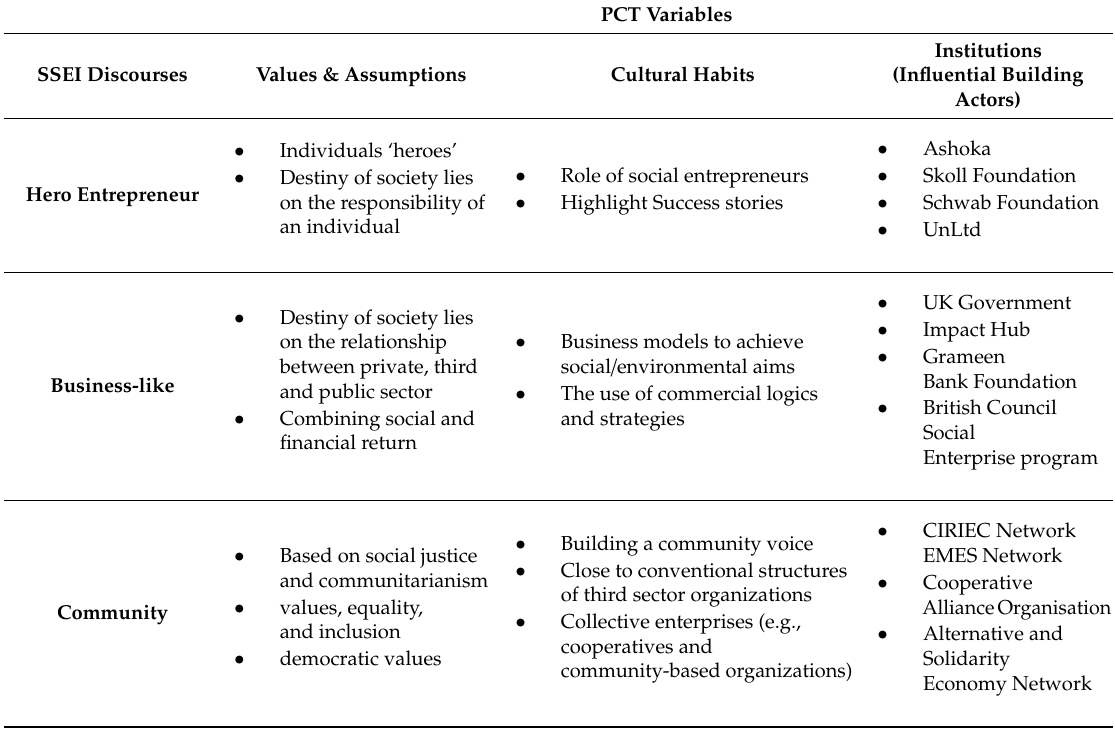
Table 1. Social economy, enterprise, and innovation (SSEI) discourses. CIRIEC: Social Economy and Cooperatives Research Network, EMES: Enterprise Research Network, PCT: postcolonial